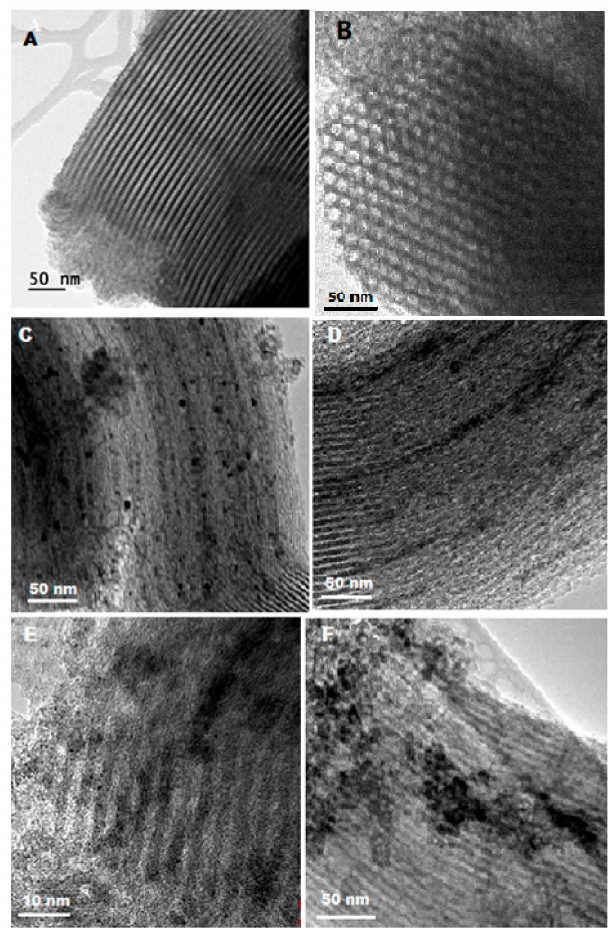
Figure 5. TEM micrographs. ( A ) BA-15; ( B ) Zr-SBA-15; ( C ) 30 V/SBA-15; ( D ) 10V/SBA-15; ( E ) 10 V/Zr-SBA-15; ( F )